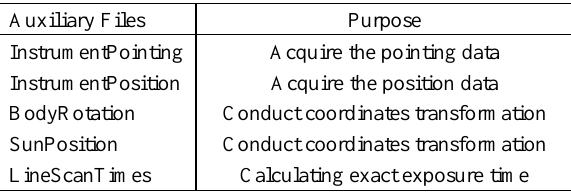
Table 1. Auxiliary files used to acquire the exterior